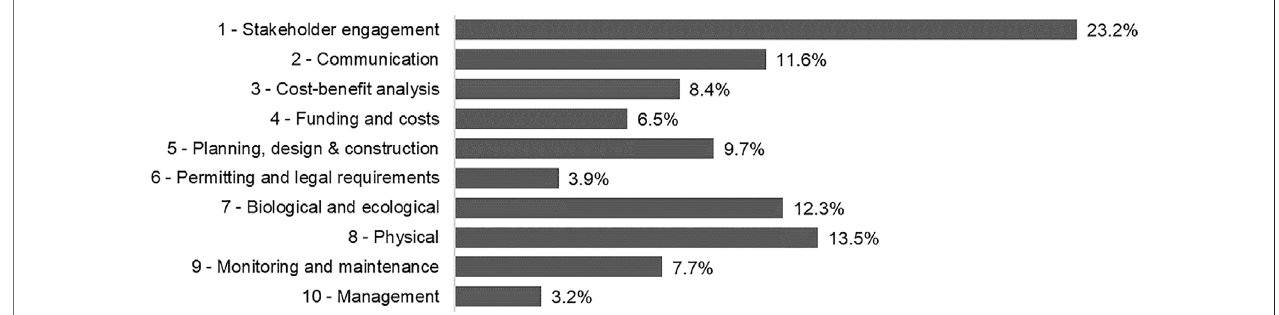
FIGURE 5 | Percentage of reported lessons learned per category de fi ned for the project sample